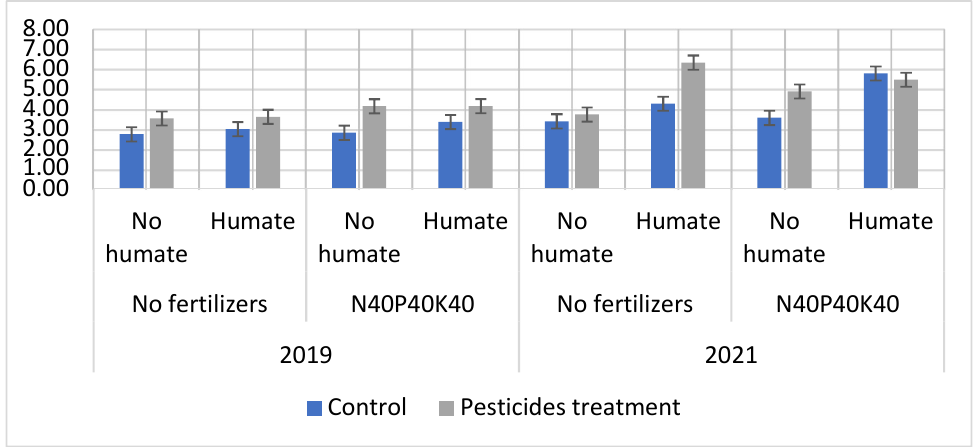
Figure 3. The influence of a humic preparation on the structure of Calcic Chernozem under peas.